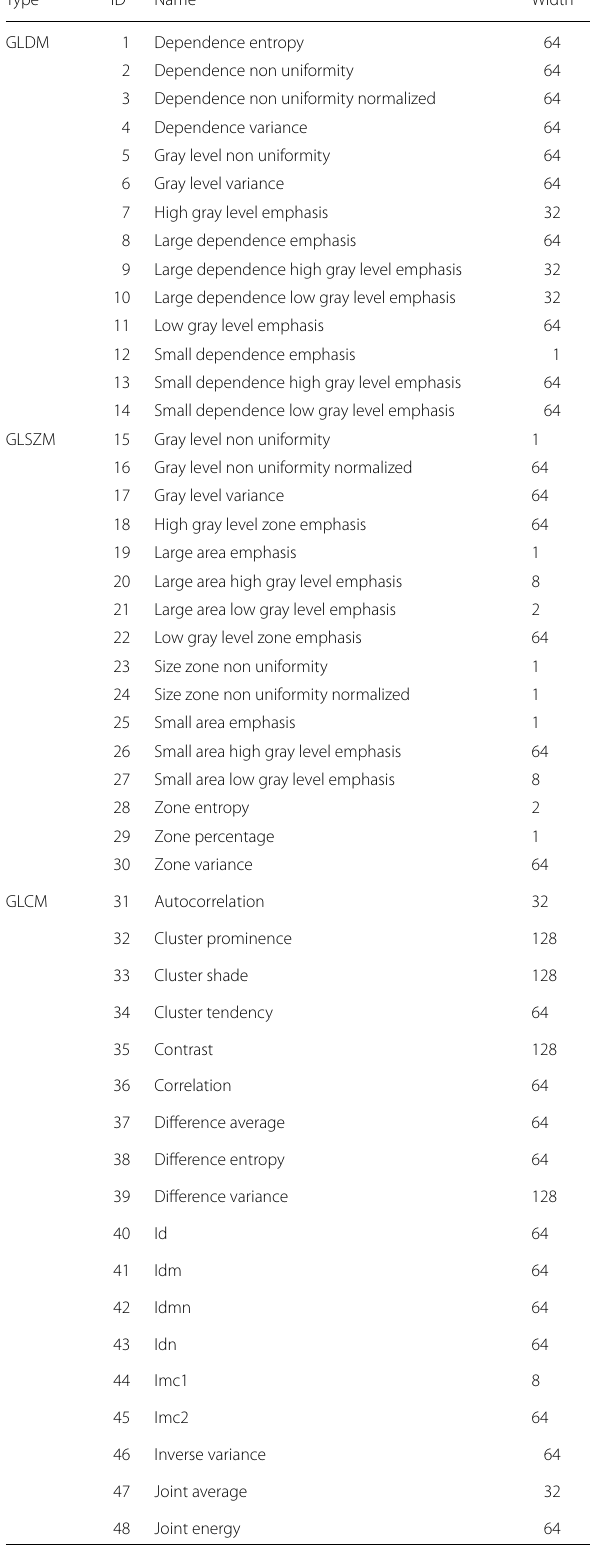
Table 2 Textural parameters used in the